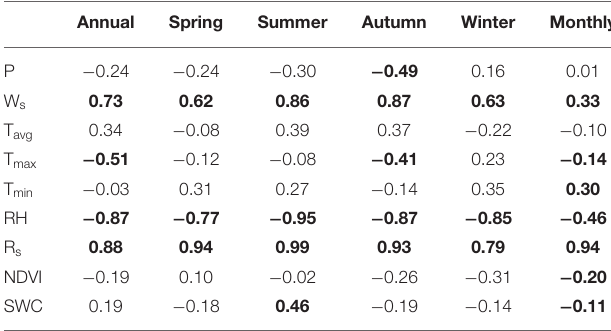
TABLE 3 | Partial correlation coefficients ( r ) between ET p and the relevant environmental